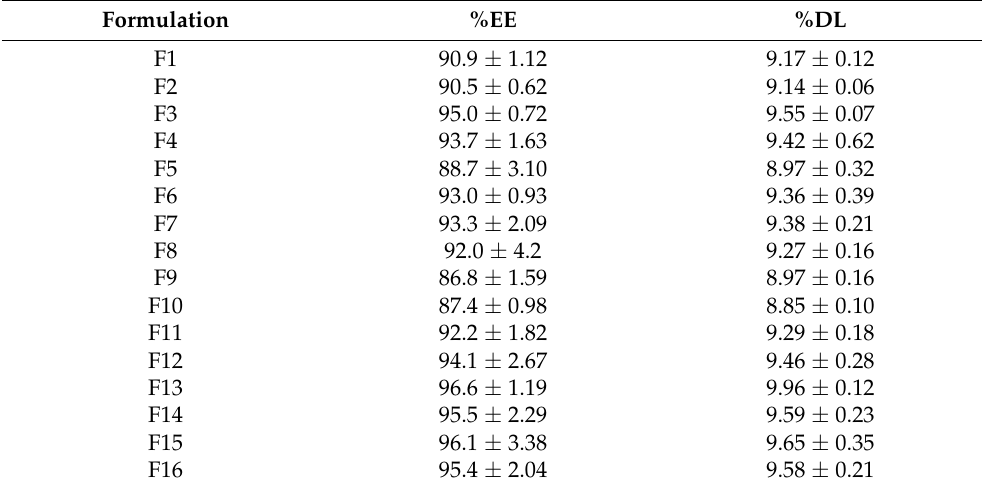
Table 2. Percentage drug entrapment efficiency (%EE) and drug loading (%DL) of all prepared SLN formulations.